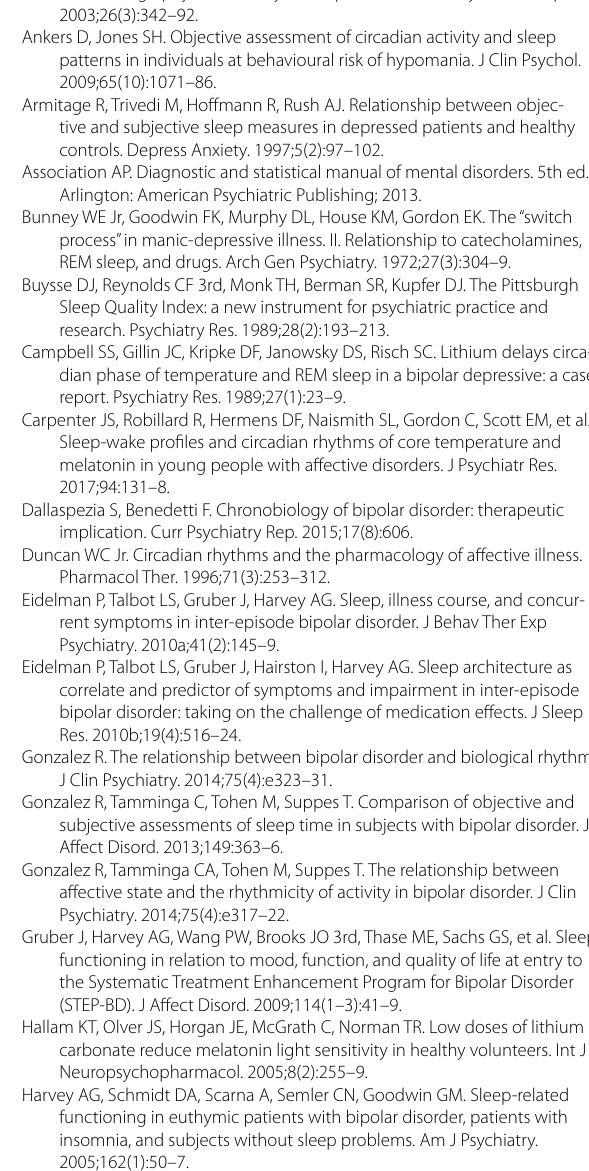
Additional file 1: Table S1. Relationships between mood and all chronobiological characteristics. Additional file 2: Table S2. Relationships between mood and cluster analysis-identified chronobiological characteristics with number of psychi- atric medications